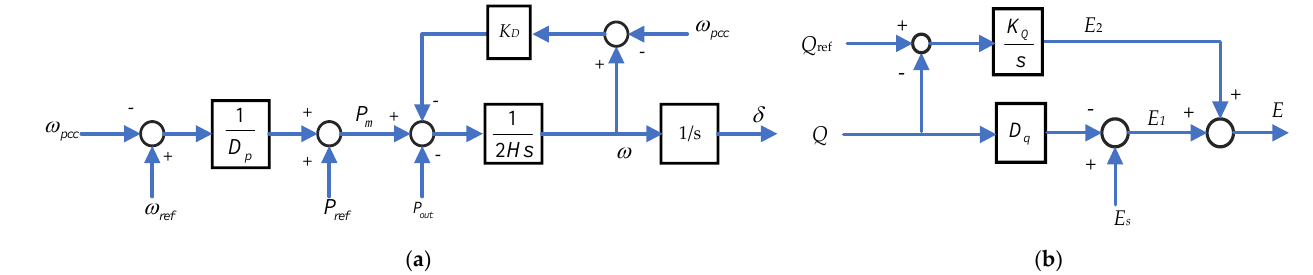
Figure 2. Block diagram of control principle. ( a ) Block diagram of the proposed frequency control. ( b ) Block diagram of voltage control.